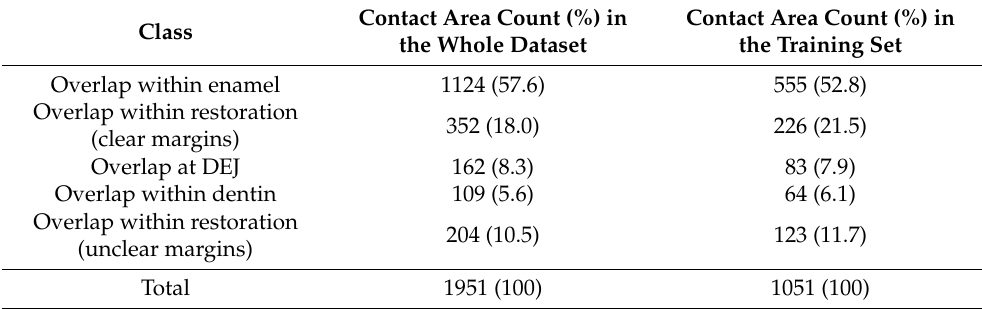
Table 1. Contact areas label